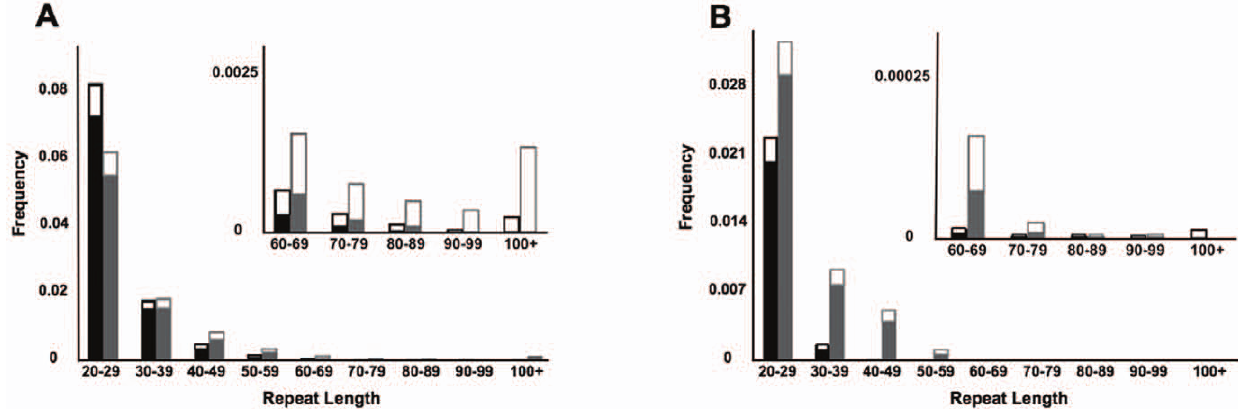
Figure 8. The distributions of repeat lengths in Drosophila and human genomes. The heights of the bars indicate the relative abundance of repeats at various lengths in Drosophila (black) and human (gray) genomes. The solid portions indicate the fraction of (A) all repeats 80% pure or greater, and (B) pure repeats that can be genotyped based on observed completeness using reads that are at least 100 bases.